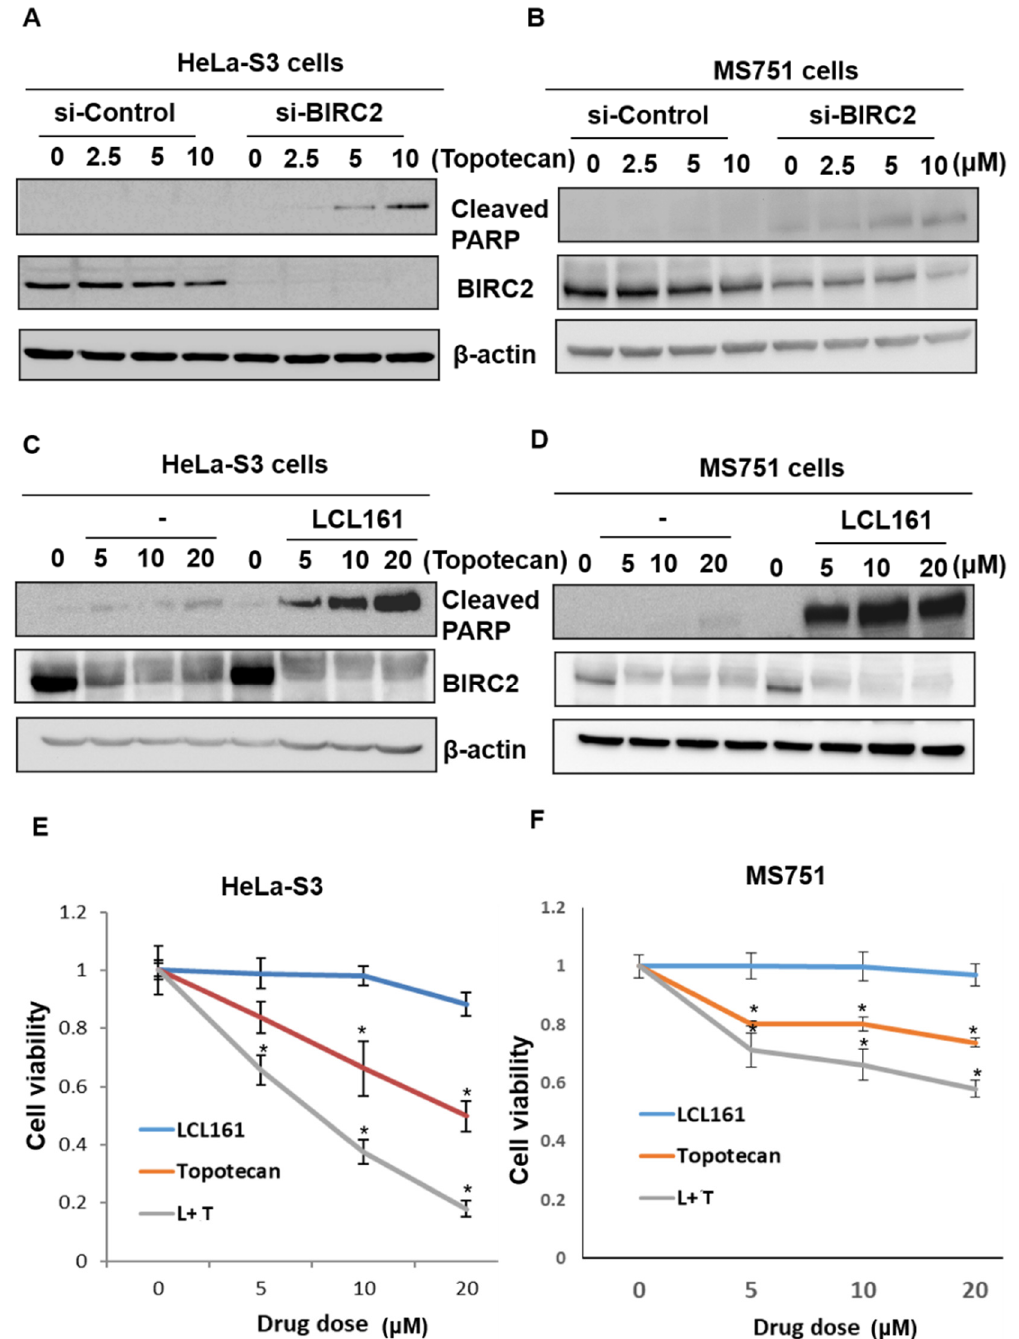
Figure 5. The combination of LCL161 and topotecan exerted synergistic effects on apoptosis and cell viability in cervical cancer cells. ( A , B ) HeLa-S3 or MS751 cells were transiently transfected with si-C or si-BIRC2 for 24 h following the addition of vehicle or varying doses of topotecan (2.5, 5, and 10 µ M) for an additional 24 h. ( C , D ) HeLa-S3 or MS751 cells were treated with LCL161 (10 µ M) for 24 h following the addition of vehicle or varying doses of topotecan (5, 10, and 20 µ M) for an additional 24 h. Subsequently, cleaved PARP, BIRC2, and β -actin were analyzed through Western blotting. For normalization, β -actin served as the loading control. ( E , F ) HeLa-S3 or MS751 cells were treated with vehicle or varying doses of LCL161 (5, 10, and 20 µ M), topotecan (5, 10, and 20 µ M), or a combination of LCL161 and topotecan (L + T) for 24 h. Cell survival was analyzed through the MTT assay. * p < 0.05 relative to controls.